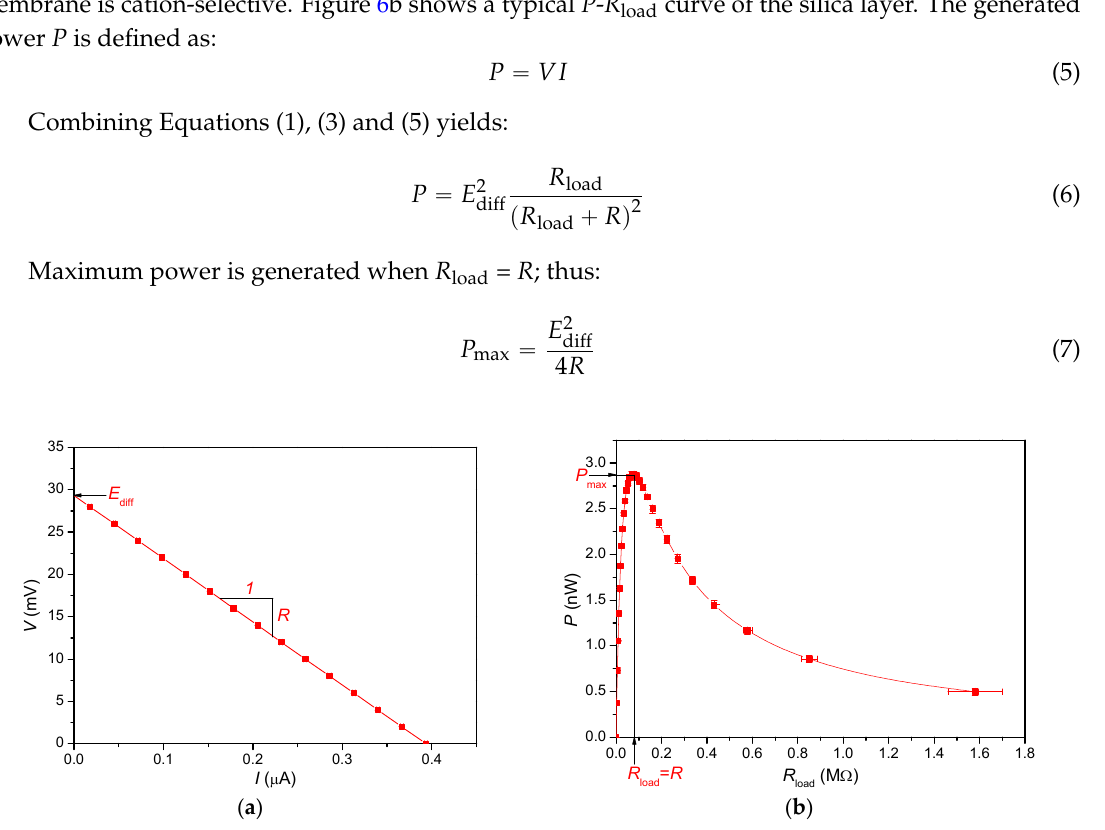
Figure 7. Transference number for various concentrations of both NaCl solutions.